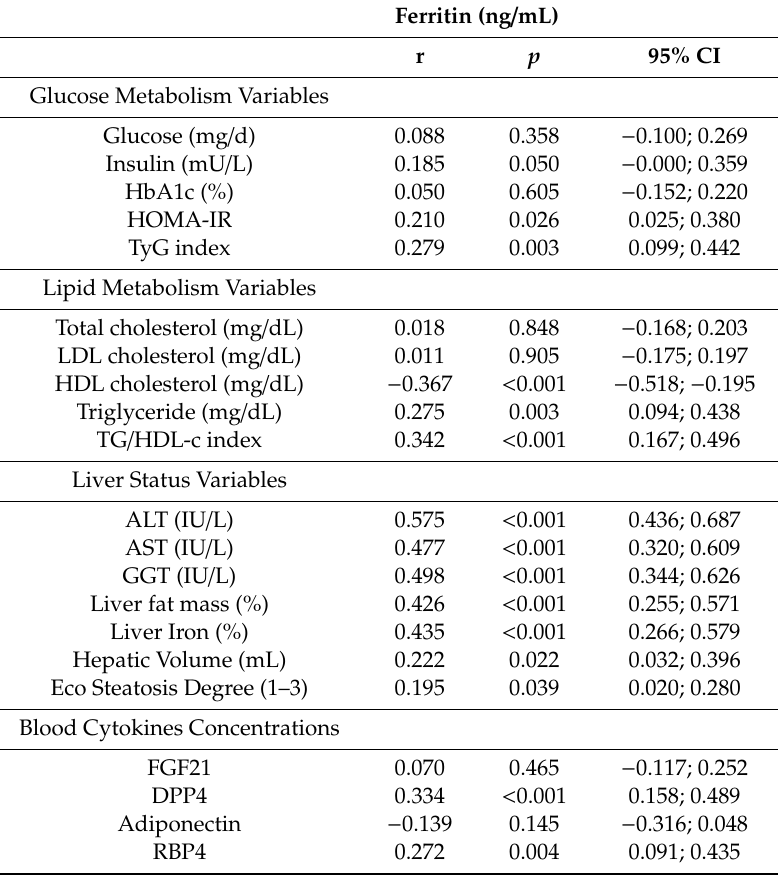
Table A3. Correlation analyses between serum ferritin levels with liver status and glucose metabolism-related